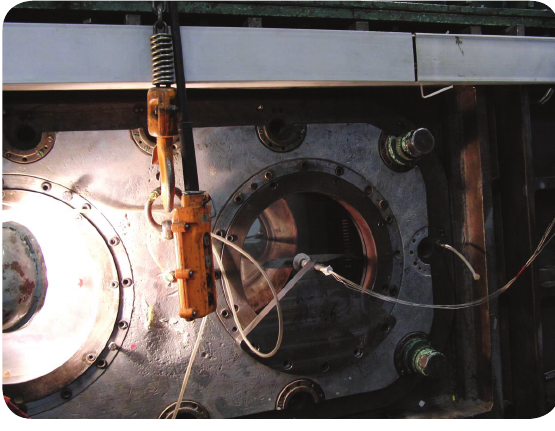
Figure 2. Model in test chamber.